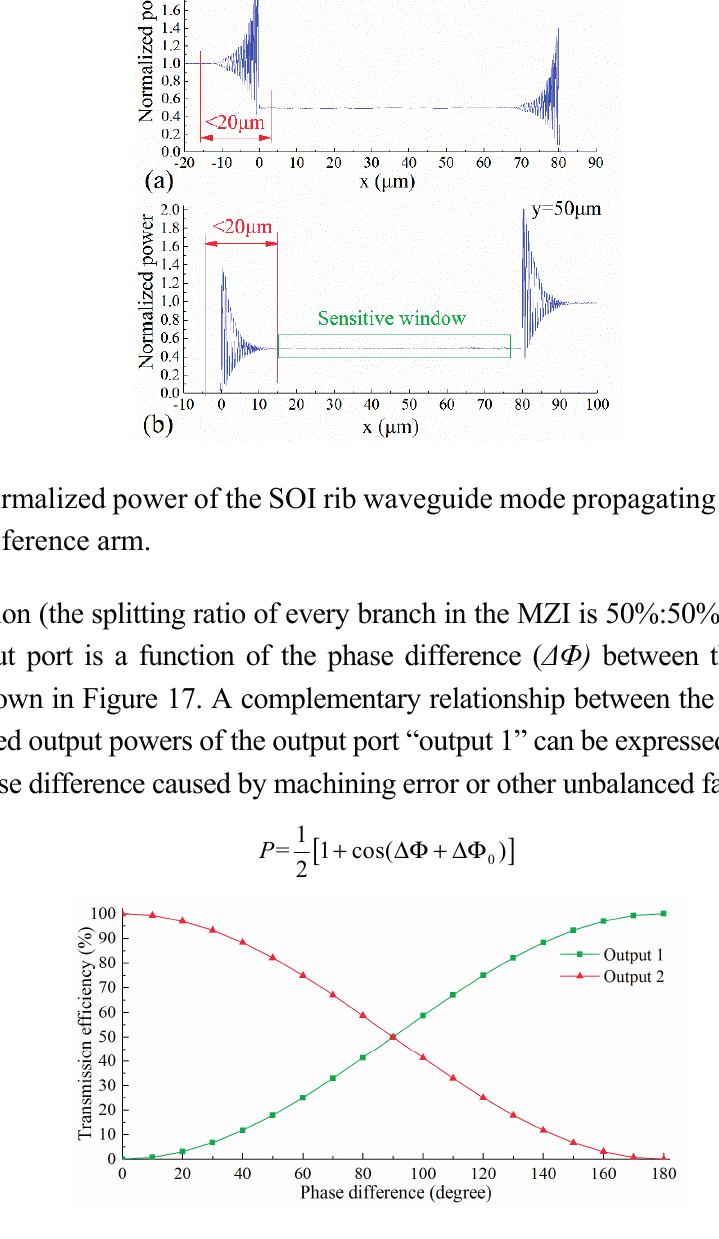
Figure 17. The normalized output power in each output port as a function of the phase difference between the sensing arm and the reference